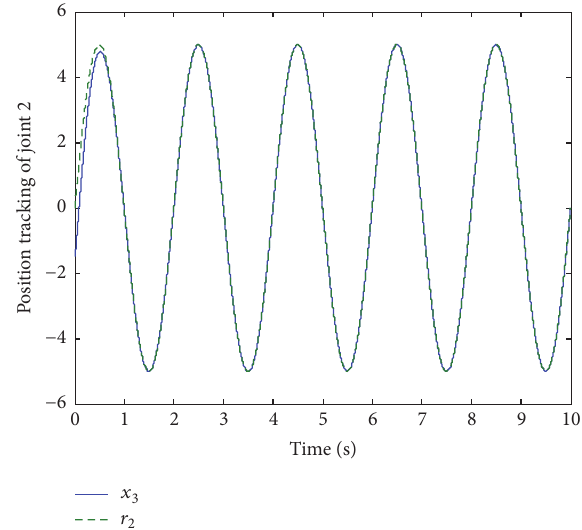
Figure 17: Actual value 𝑥 3 and tracking state of input signal 2.